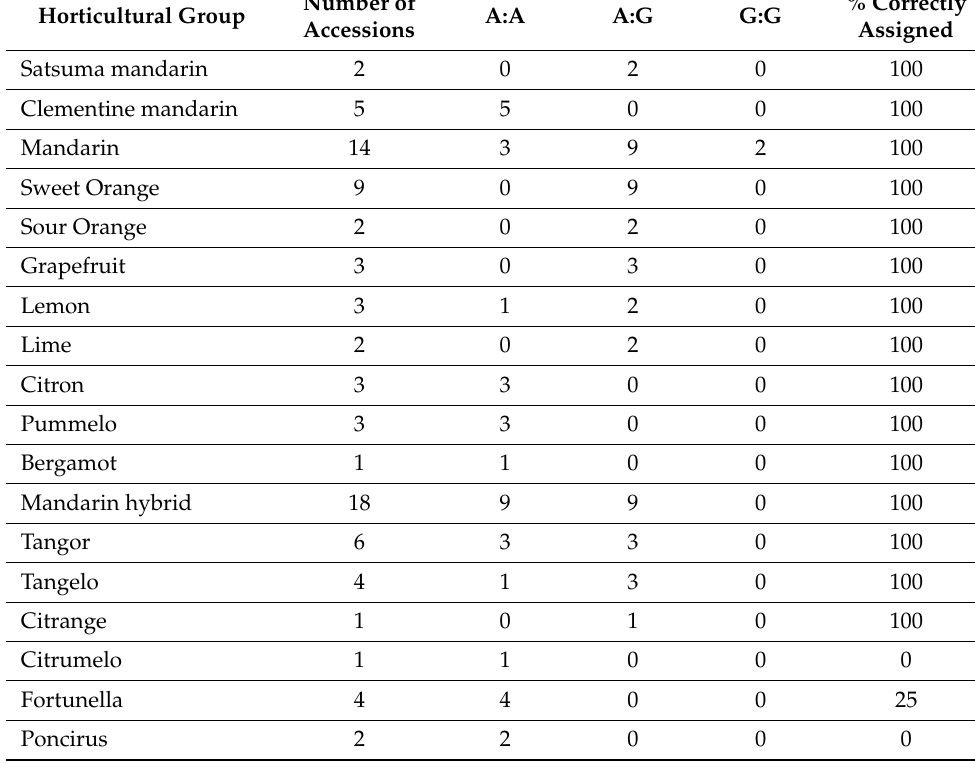
Table 4. Horticultural groups with the number of accessions analyzed with the S01_25497528 SNP